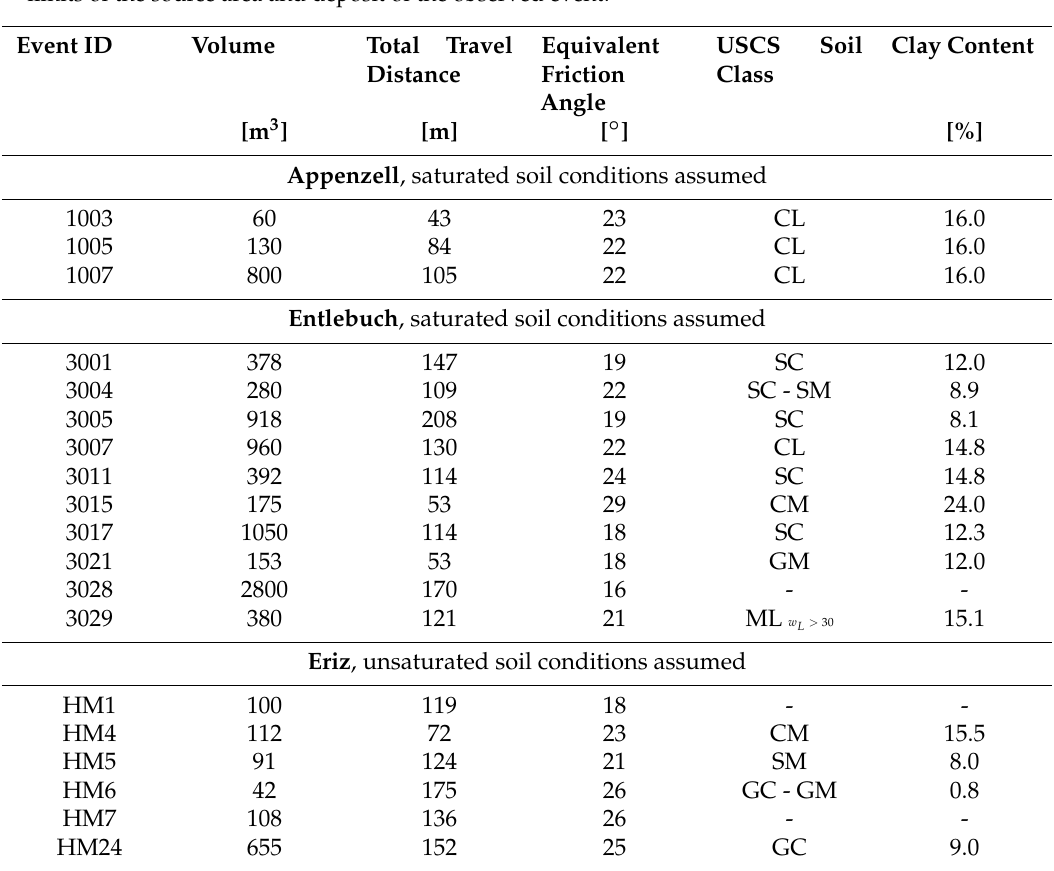
Table 1. Characteristics of 19 hillslope debris-flow events in the regions of Appenzell (2002), Entlebuch (2005) and Eriz (2012) in Switzerland, based on event documentations [38,40,41] and soil analysis. The equivalent friction angle refers to the mean gradient of the flow path, estimated from the distal limits of the source area and deposit of the observed